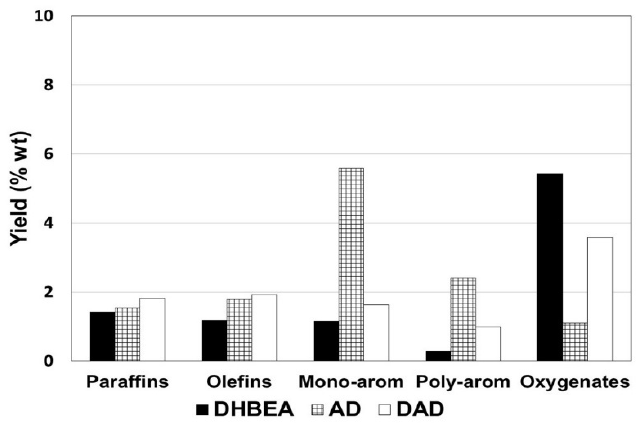
Figure 3. Yields of organic liquid products obtained by cracking 30% DX/n-hexane over DHBEA, AD, and DAD, 500 mg of catalyst at 500 °C. Legend: Mono-arom—monoaromatics; Poly-arom—polyaromatic; DHBEA (Hydrothermally treated beta zeolite); AD (Fresh beta catalyst) and DAD (Hydrothermally treated beta catalyst).